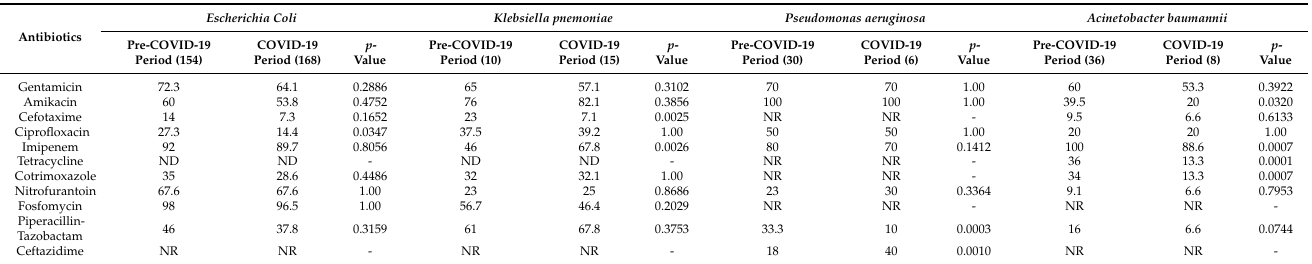
Table 5. Comparison of antimicrobial susceptibility pattern of Gram negative bacteria in urine samples between pre-COVID- 19 and COVID-19 period.